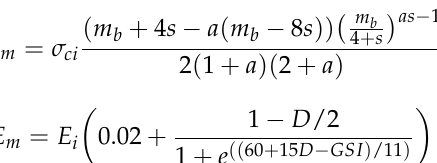
Figure 7. ( a ) UCS model. ( b ) Stress-strain curve of the coal mass sample under an ideal rigid loading condition.